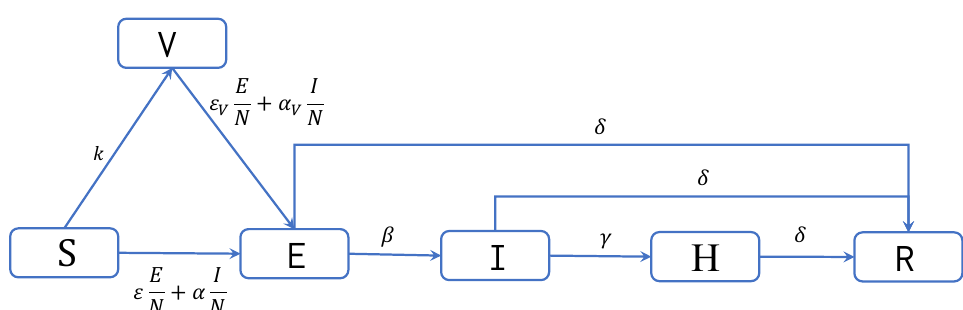
Figure 1. Diagram of the SVEIHR model. Individuals in the model transition between the six states of the model in accordance to the labeled per-individual transition rates between states. The “recovered” (R) state is always a final state, while the “susceptible” (S) and “vaccinated” (V) states become final if there are no longer any “exposed” (E) or “infected” (I) individuals in the